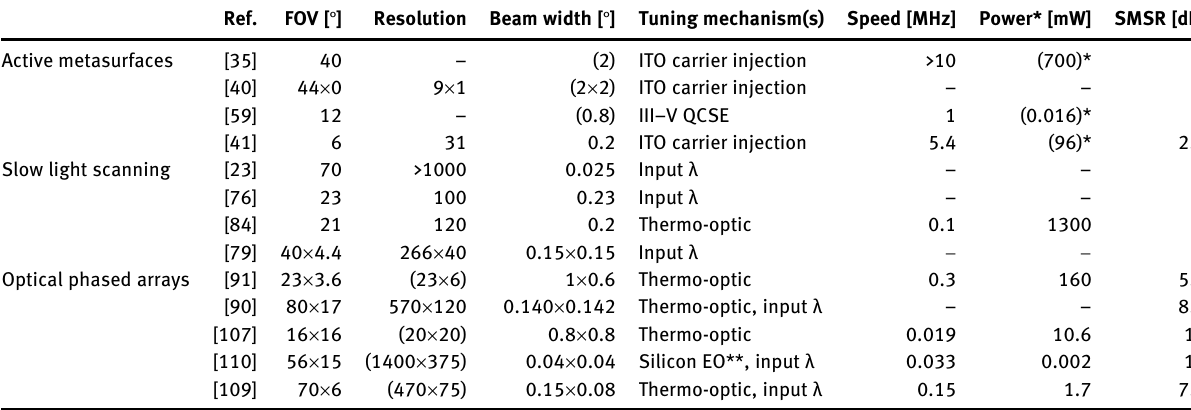
Table  : Comparisonof notablebeamsteeringworksfromeachdevicearchitecture.FOV,resolution, andbeamwidtharereportedas asingle number for  D steering. All values are experimental except those in parentheses, which are derived. Abbreviations: Input λ : input wavelength tuning; EO: electro-optic effect; QCSE: quantum-con fi ned Stark effect.